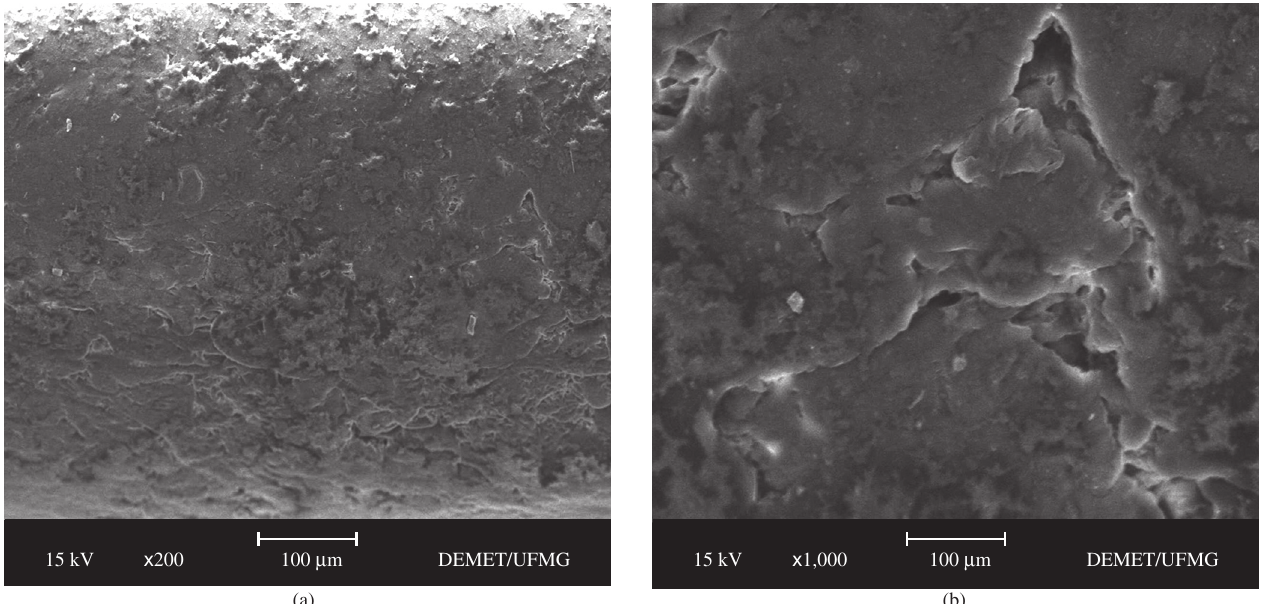
Figure 2. SEM pictures from the mixture lyophilized implant before in vitro incubation a) magnification 200 x ; b) magnification 1,000 x , with just minor porosity at the surface.